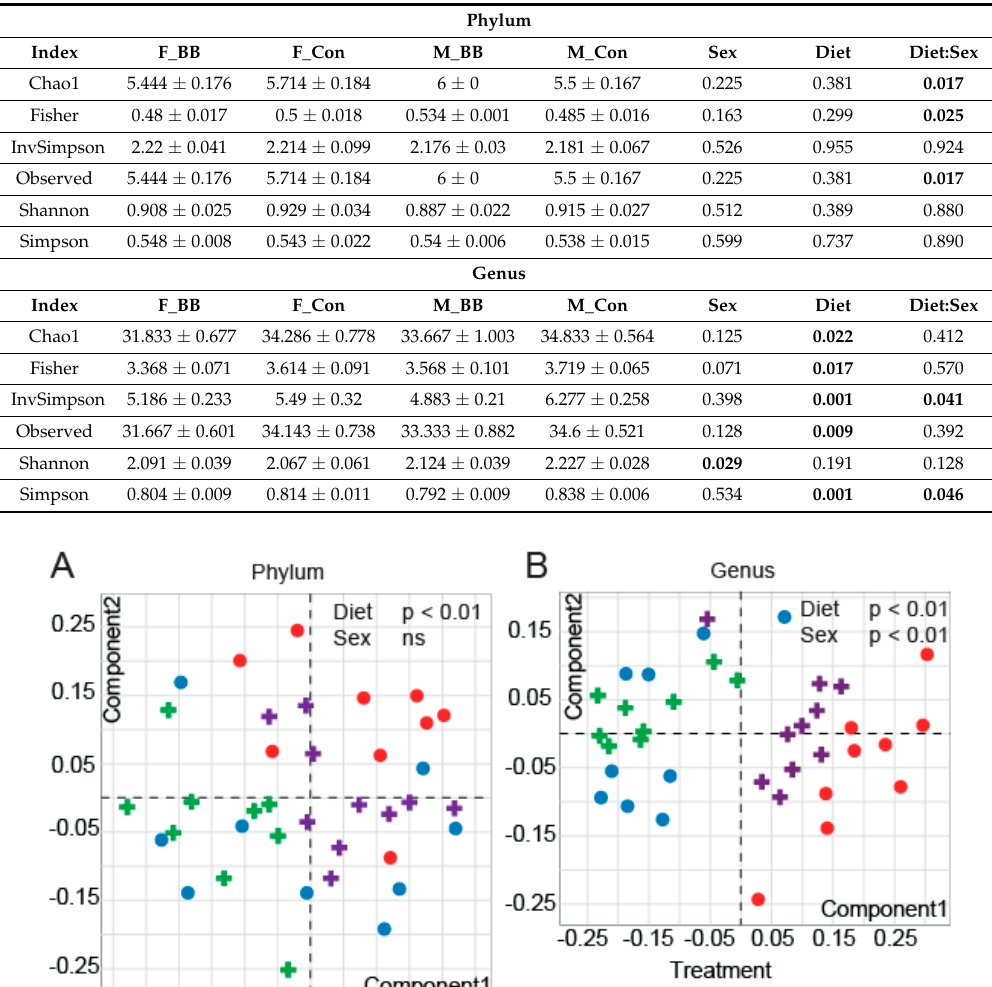
Table 2. α -diversity indices at the phylum and genus levels (Data are expressed as mean ± SE). Statistical differences between the groups (F-BB (female mice fed a blueberry diet) ( n = 9), F-Con (female mice fed a control diet) ( n = 7), M-BB (male mice fed a blueberry diet) ( n = 9), and M-Con (male mice fed a control diet) ( n = 10) were determined by Two-Way ANOVA for sex and diet and their interaction (bold typed numbers state the significantly different indices).